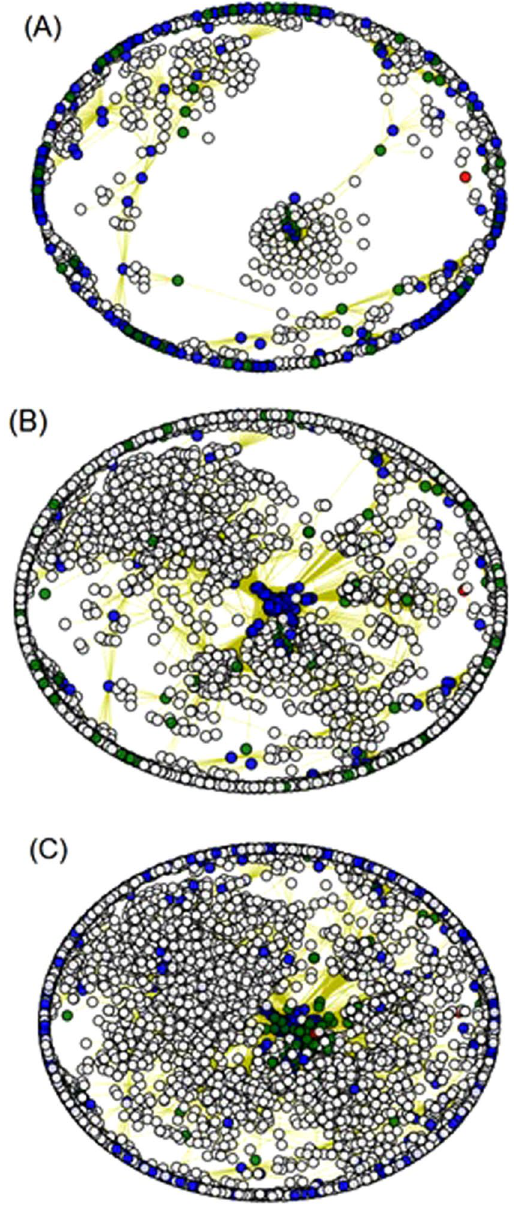
Figure 5. The coexpression network related to two CCS biclusters from GDS589. The blue, green and white nodes represent the genes from bicluster 1, bicluster 2 and the neighboring genes respectively. Red nodes are common genes between bicluster 1 and 2. Edges represent correlation >= 0.8 or <=− 0.8. ( A ) Coexpression network based on correlations over all the samples in GDS589. ( B ) Coexpression network based on correlations over the samples of bicluster 1 ( C ) Coexpression network based on correlations over the samples of bicluster CCS biclusters are equivalent to condition-dependent coexpression network modules. A net- work module is usually defined as a highly connected sub-network. A module in coexpression network consists of a group of genes whose expression levels are highly correlated 32 . The correlative relations in a coexpression network often depends on conditions such as genotype, environment, treatment, cell type, disease state or devel- opmental stage 33–38 . Therefore, coexpression network modules may also change with those conditions. There is an interesting relation between CCS biclusters and coexpression network modules. A CCS bicluster consists of genes whose expression levels are highly correlated under a set of conditions. Therefore, a CCS bicluster is equivalent to a condition-dependent module in a coexpression network. This has been illustrated here from two CCS-biclusters. We picked two CCS-biclusters from GDS589 dataset. The first bicluster (bicluster 1) includes 166 genes and 70 samples. The second bicluster (bicluster 2) includes 81 genes and 60 samples. We also identified all the neighboring genes of the biclusters. Neighboring genes are the genes that are not from a bicluster but they are correlated with at least one gene in that bicluster. Figure 5(A) shows the coexpression network of the genes in